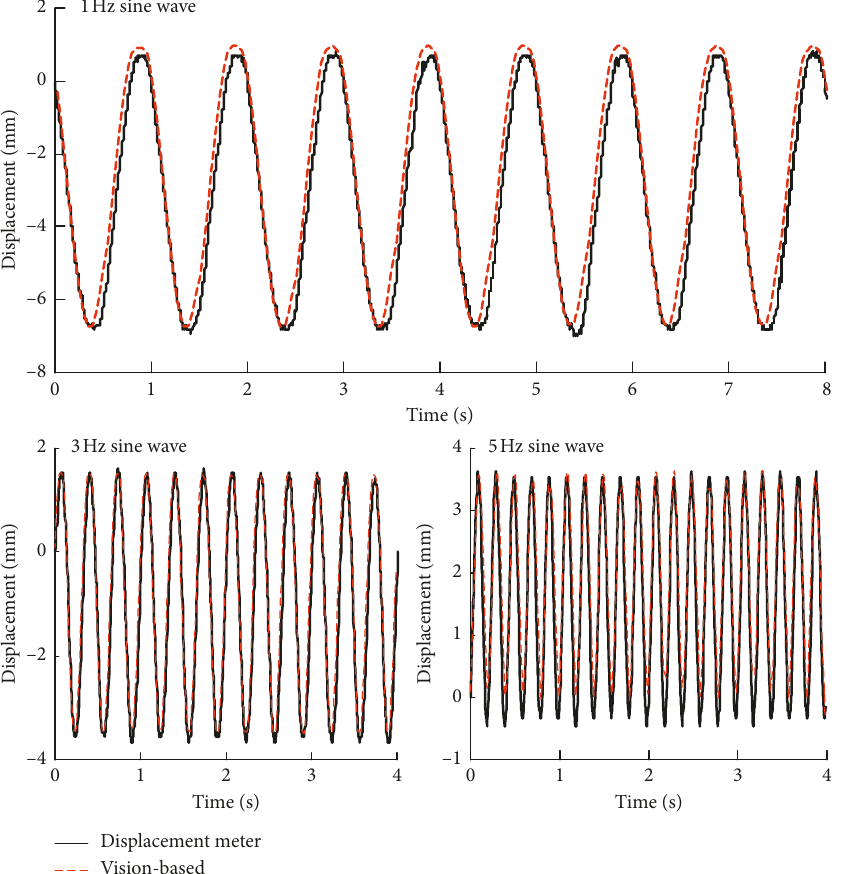
Figure 6: Displacement comparison charts obtained by different displacement test methods under different waves. (a) 1 Hz sine wave. (b) 3Hz sine wave. (c) 5 Hz sine